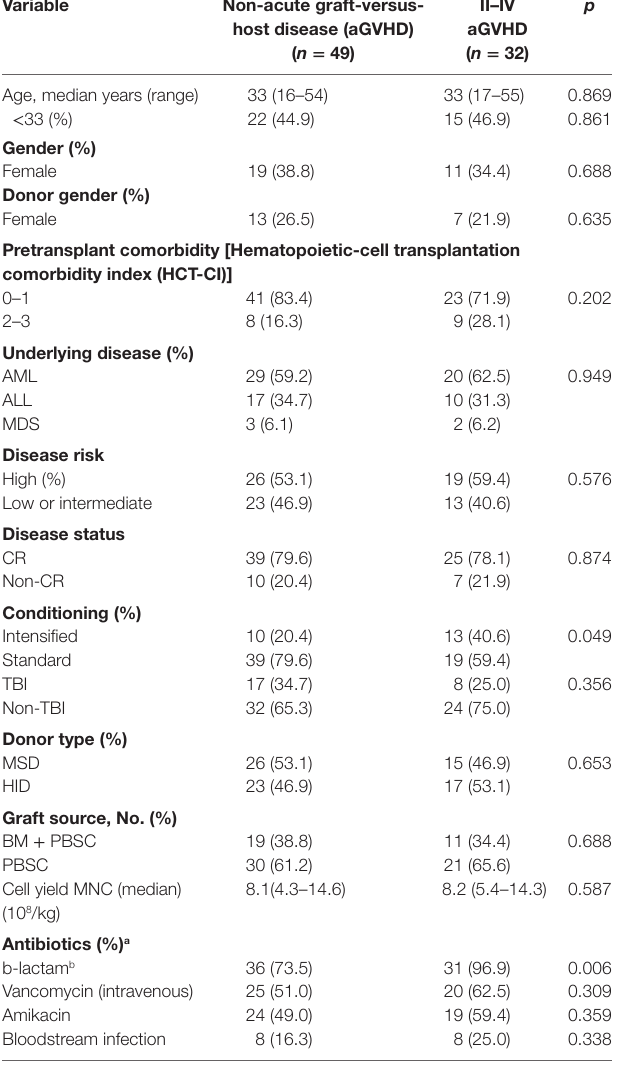
TaBle 1 | Patient and transplant characteristics.